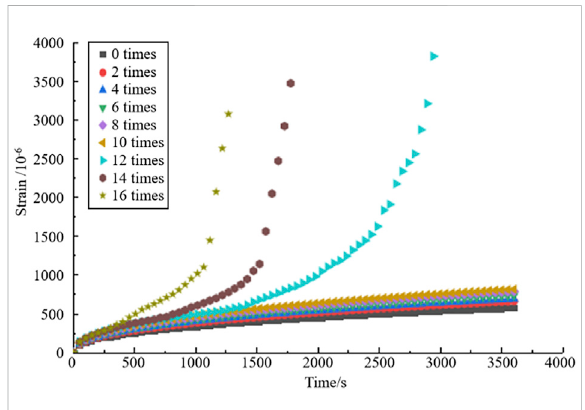
FIGURE 11 Freeze-thaw creep curves of composite modi fi ed OGFC at mixing ratios of (12%,2%).